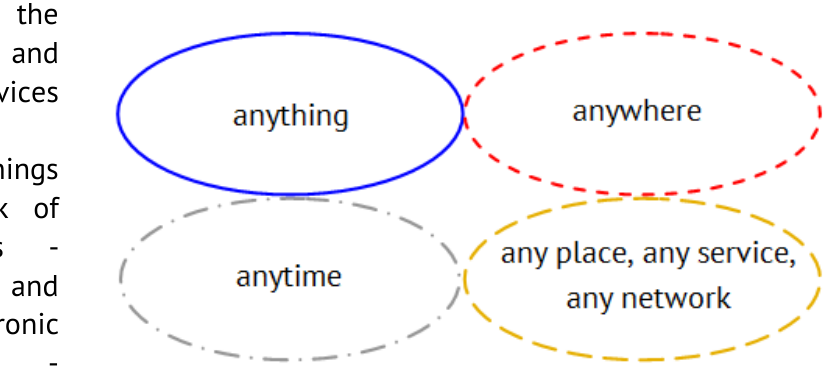
Figure 3. Connectivity with the Internet of